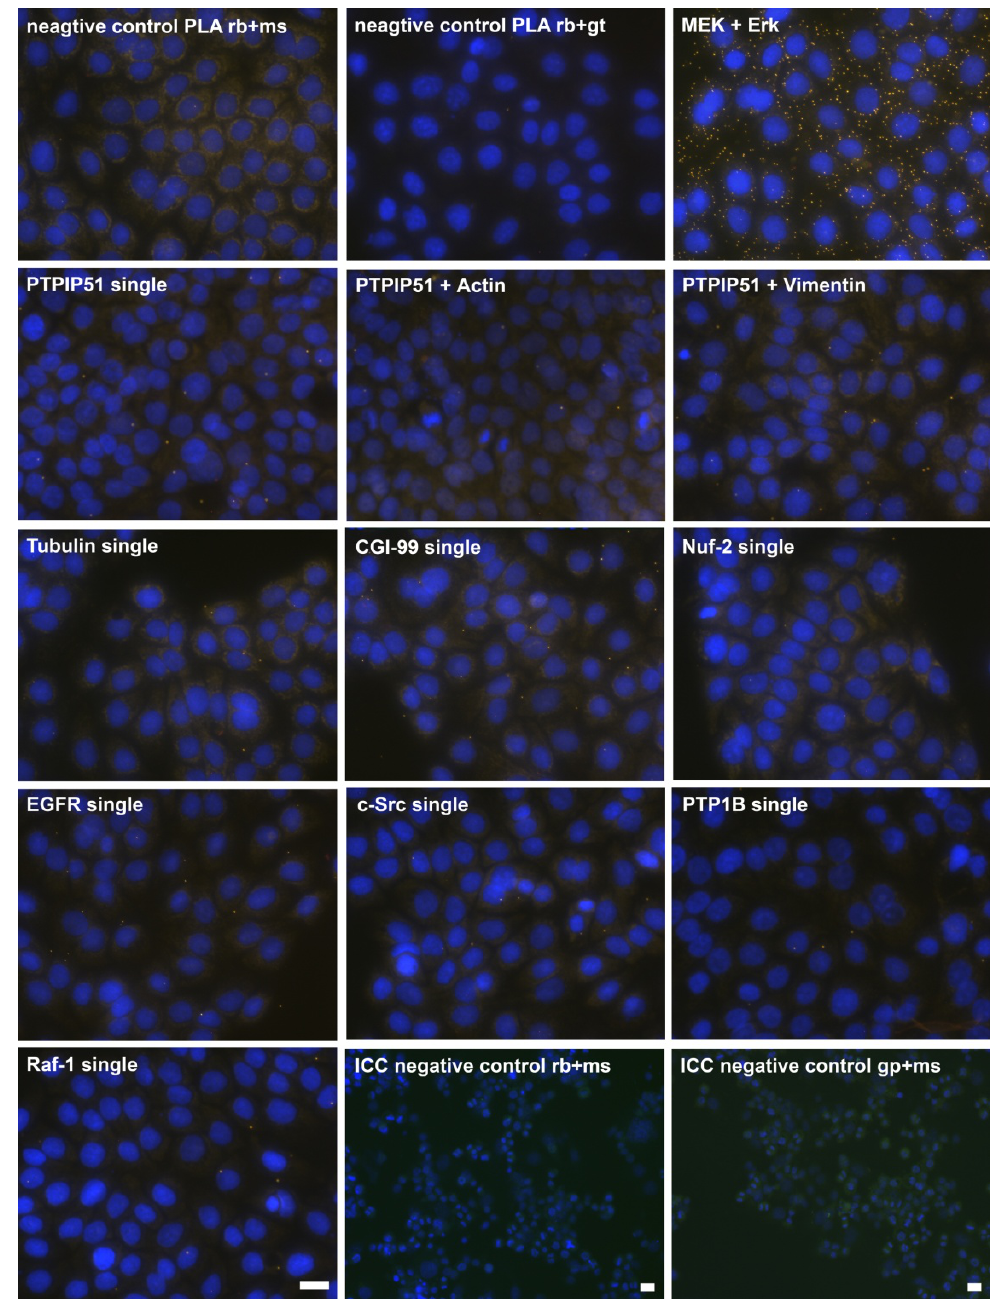
Figure 2. Control experiments of the Duolink II Proximity Ligation Assay (DPLA) specifity. Negative controls were done for both rabbit and mouse PLA probe and rabbit and goat PLA probe (omission of all primary antibodies). The positive control was done using two antibodies against MEK and Erk, respectively. PTPIP51 interaction with the cytoskeleton was tested by using an actin and vimentin antibody. All antibodies used for DPLA were tested in single staining experiments using the appropriate mixture of PLA probes. Immunocytochemistry (ICC) negative controls were done for the Cy3 donkey anti-rabbit/Alexa Fluor 488 goat anti mouse IgG (ICC negative control rb+ms) mixture and Cy3 donkey anti-guinea pig/Alexa Fluor 488 goat anti mouse IgG (ICC negative control gp + ms) mixture (omission of the primary antibodies for PTPIP51 and Tubulin). Bar: 20